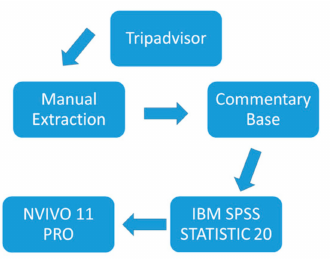
Figure 1. Methodology design. Source: Own elaboration.